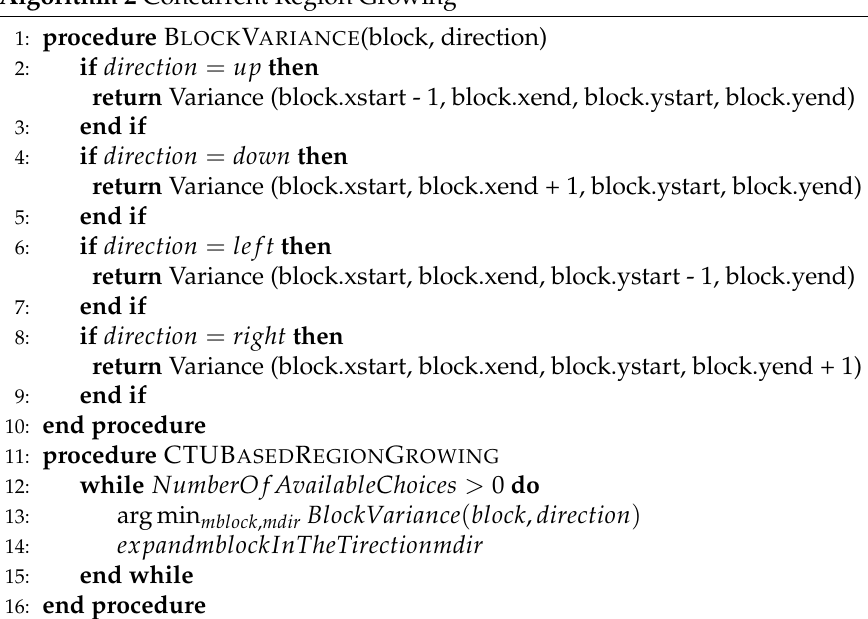
Algorithm 2 Concurrent Region